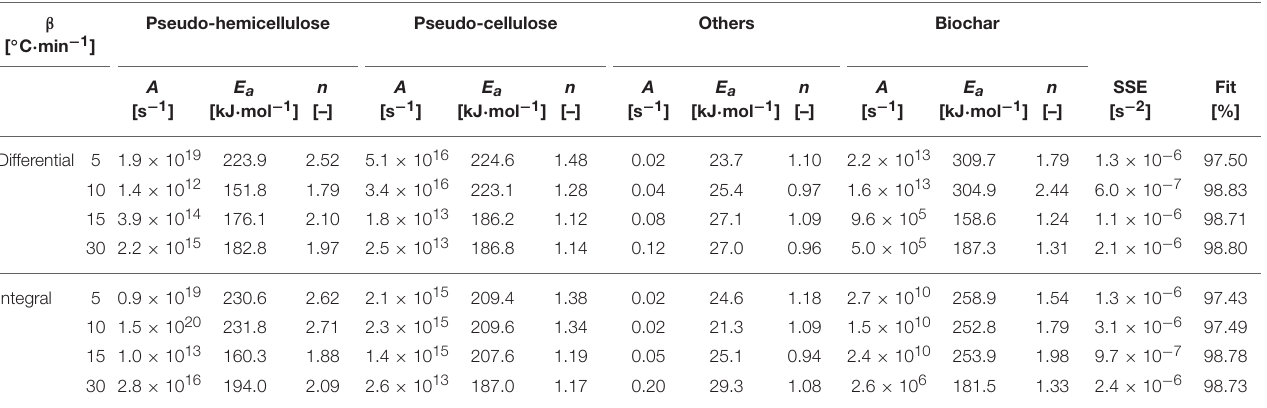
TABLE 7 | Optimized kinetic parameters of